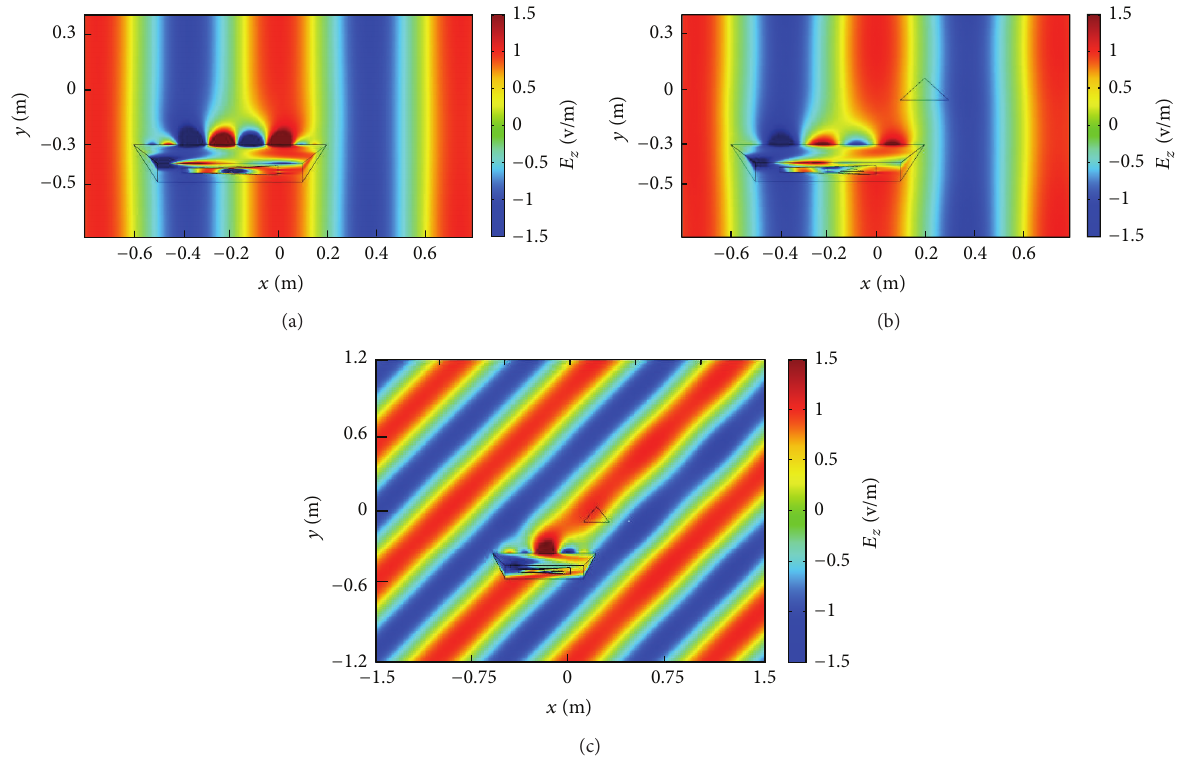
Figure 5: Electric field distributions for the trapezoid complementary illusion cloak: (a) without target object; (b) with target object for a normally incident wave; (c) with target object for an obliquely incident